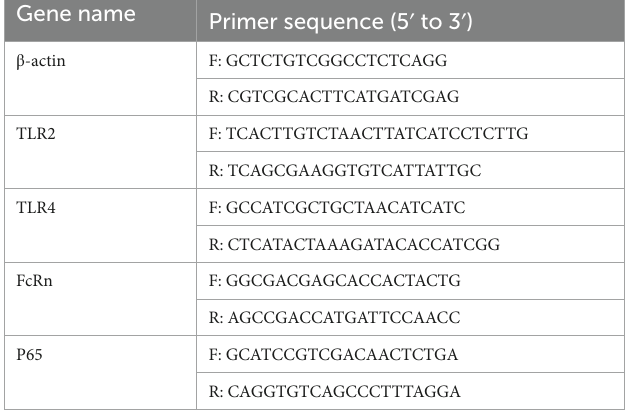
TABLE 1 Primers used for real-time PCR